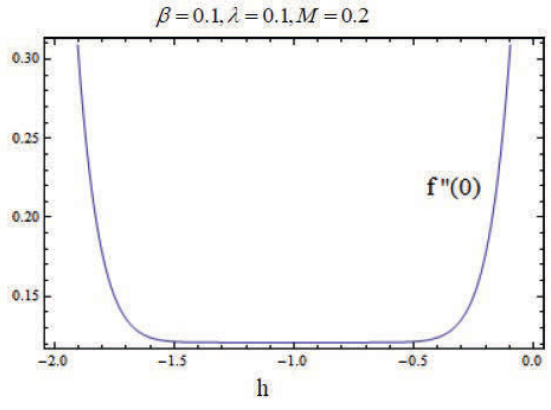
Fig. 2: h f curve for functions f for 20 th -order of HAM approxima- tions.